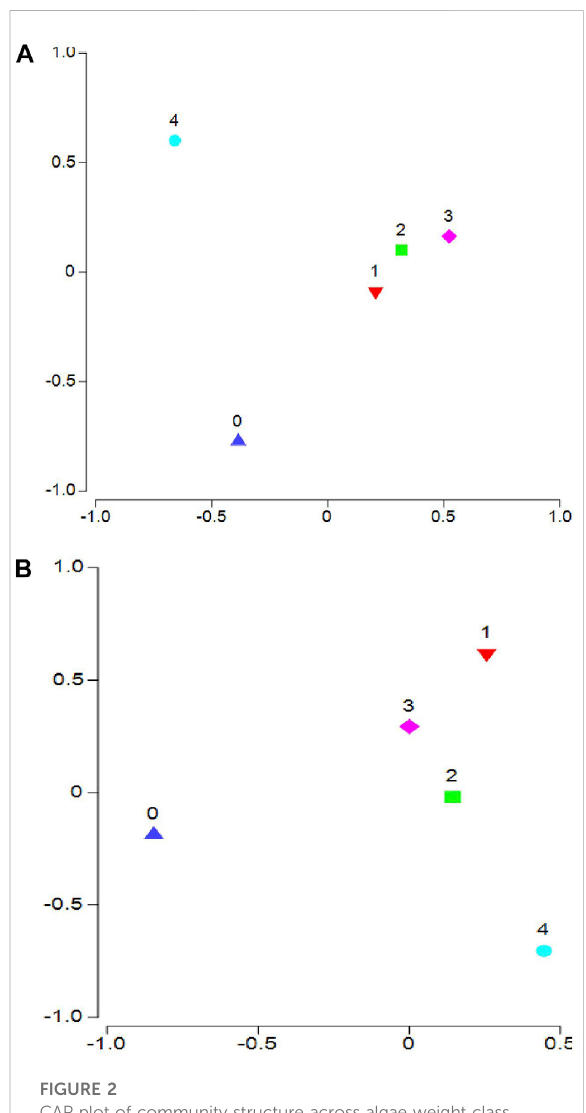
FIGURE 2 CAP plot of community structure across algae weight class. CAP plot comparing communities during the early summer across averaged algae weight classes. Comparisons were run using the complete data set (A) and a subset of the data, in which the turtlegrasspercentcoverwas > 75%cover andtheaveragecanopy height was between 200 and 400 mm (B) . Classi fi cationsincluded microbenthic sledsamples where no algae werepresent(0), along with areas containing up to 300 g (1), 301 – 500 g (2), 501 – 1,000 g (3), and over 1,000 g (4) of